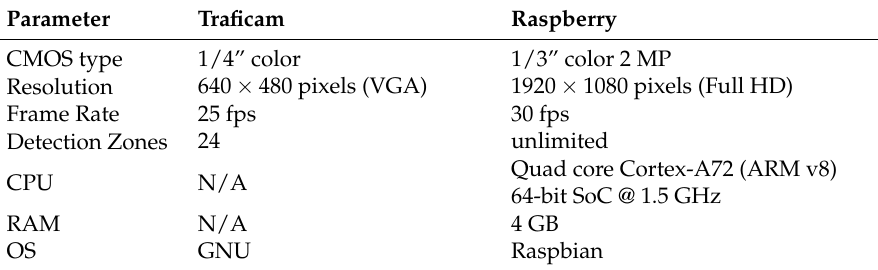
Table 1. Testbed